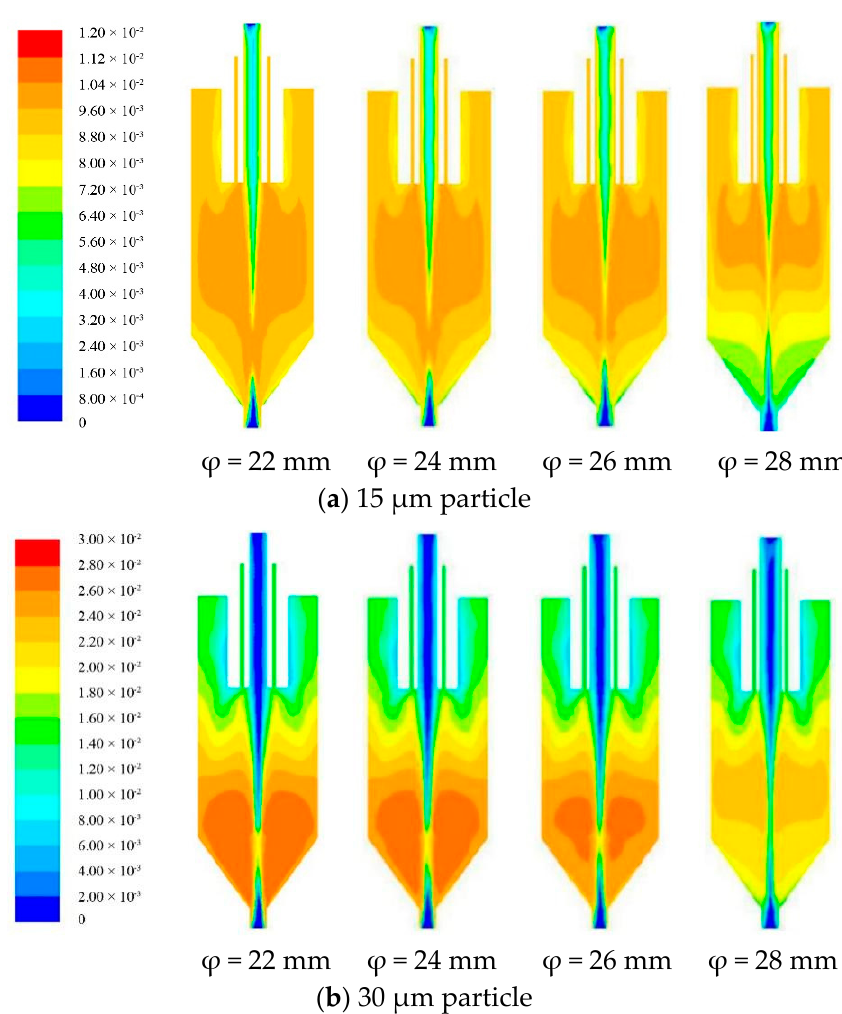
Figure 5. Particle distributions for different internal vortex finder diameters.